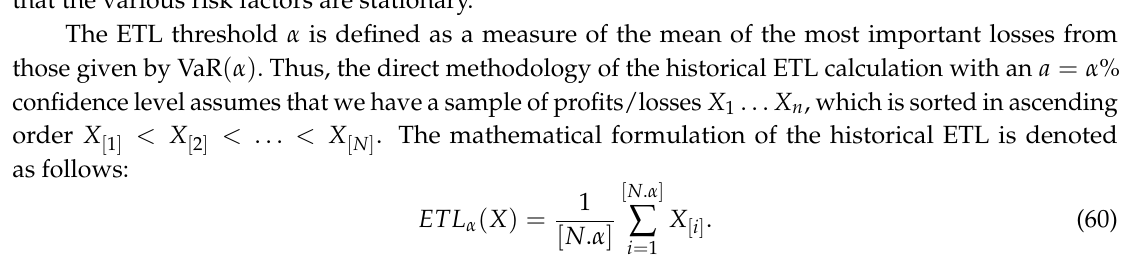
Table 8. Calculation of the historical Expected Tail Loss (ETL) for 30 June 2017.